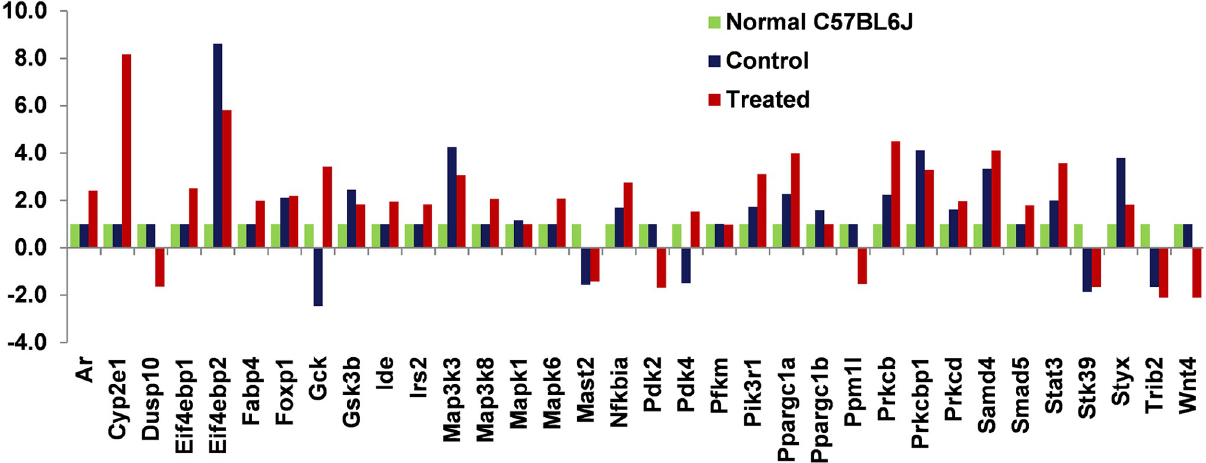
Fig 5. Microarray analysis of differential expression of genes in skeletal muscle of treated and control animals, with respect to age matched, normal chow fed male C57BL6J mice. Microarray analysis showing differences in the expression levels of various genes involved in glycemic control in the skeletal muscle of the treated and control animals after 32 weeks of treatment, with respect to age matched, normal chow fed male C57BL6J mice.